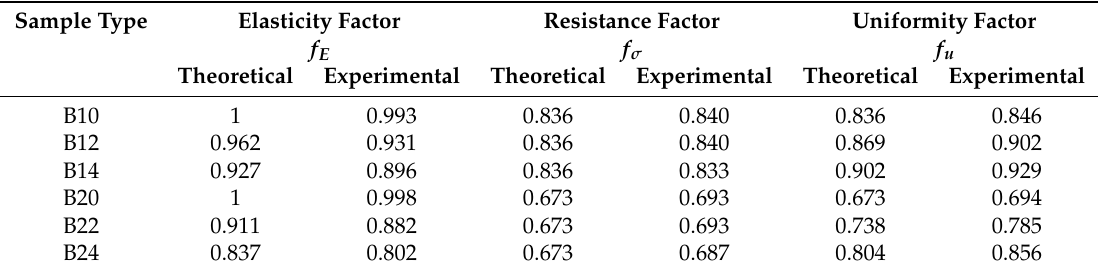
Table 5. Quality factors for composites reinforced by type “B”